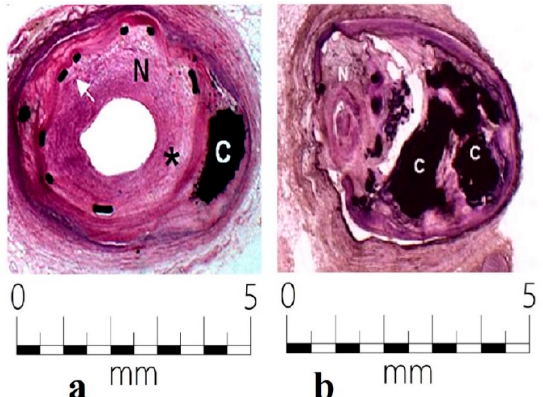
Figure 15. Cross section of RCA for: ( a ) sample P14 showing 70% ISR (N) and calcified atheroma plaque (C) can be observed. Arrows show stent struts and the absence of stent struts is indicated by the asterisk (*); ( b ) sample P18 with peripheral calcifications (C) compressed behind the stent threads and the arterial lumen almost completely restenosed (N).